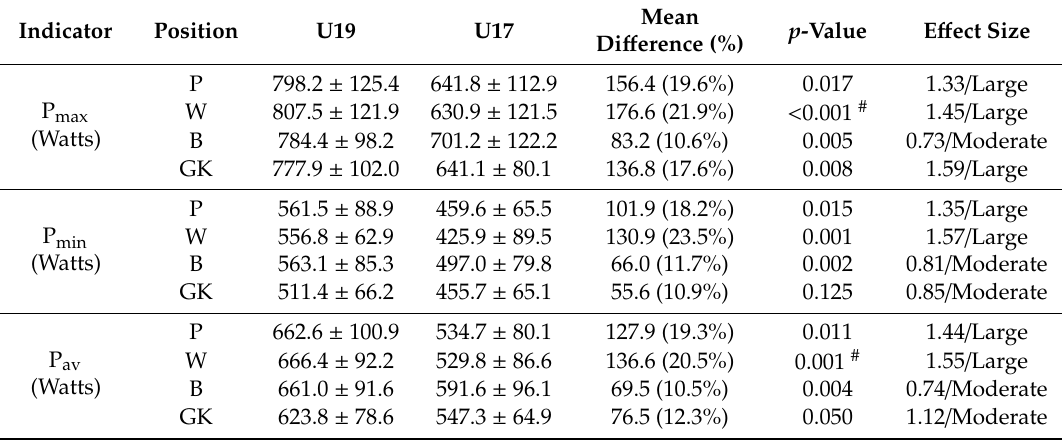
Table 4. Absolute power (watts) produced in the players of various playing positions, recorded in RAST.